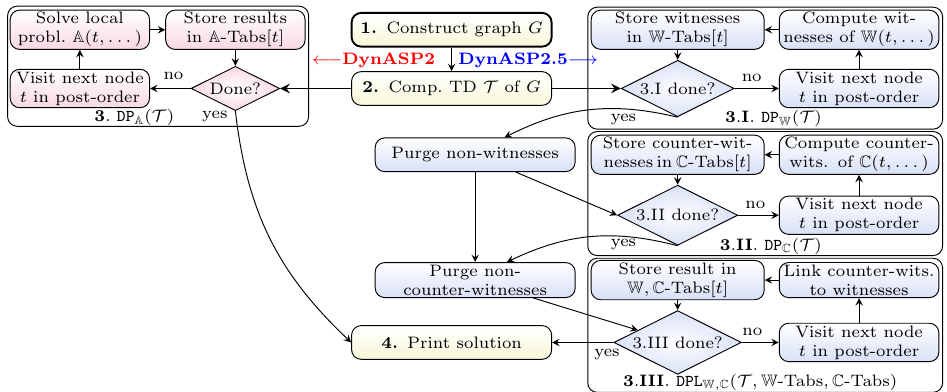
Figure 4. Control flow for DP-based ASP solver (DynASP2, left ) and for DynASP2.5 ( right